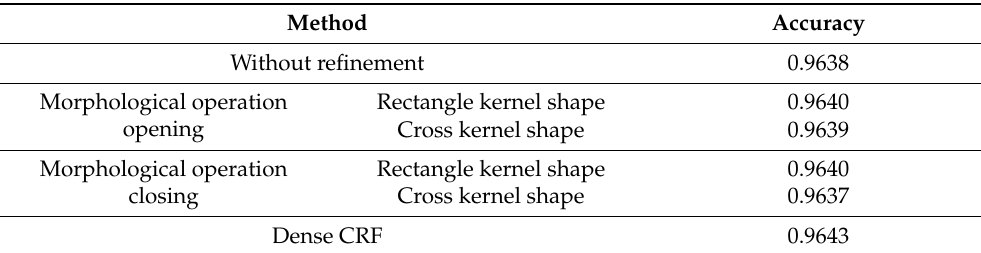
Table 7. Quantitative analysis of binary mask refinement methods.